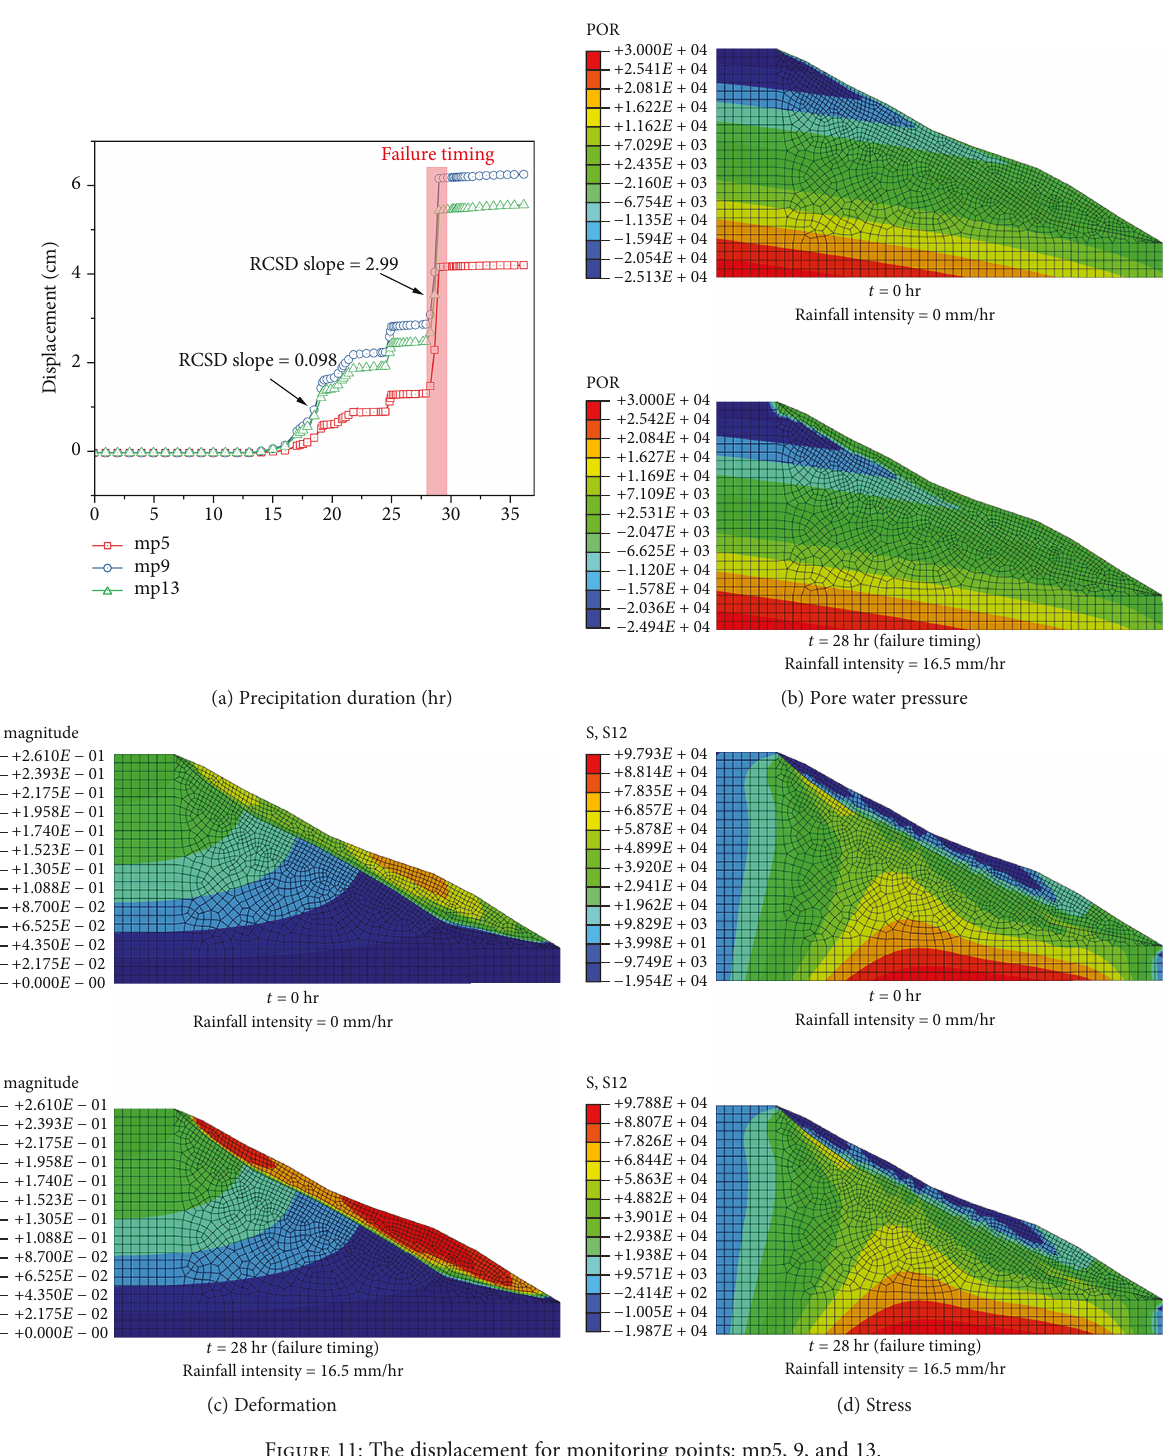
Figure 11: The displacement for monitoring points: mp5, 9, and